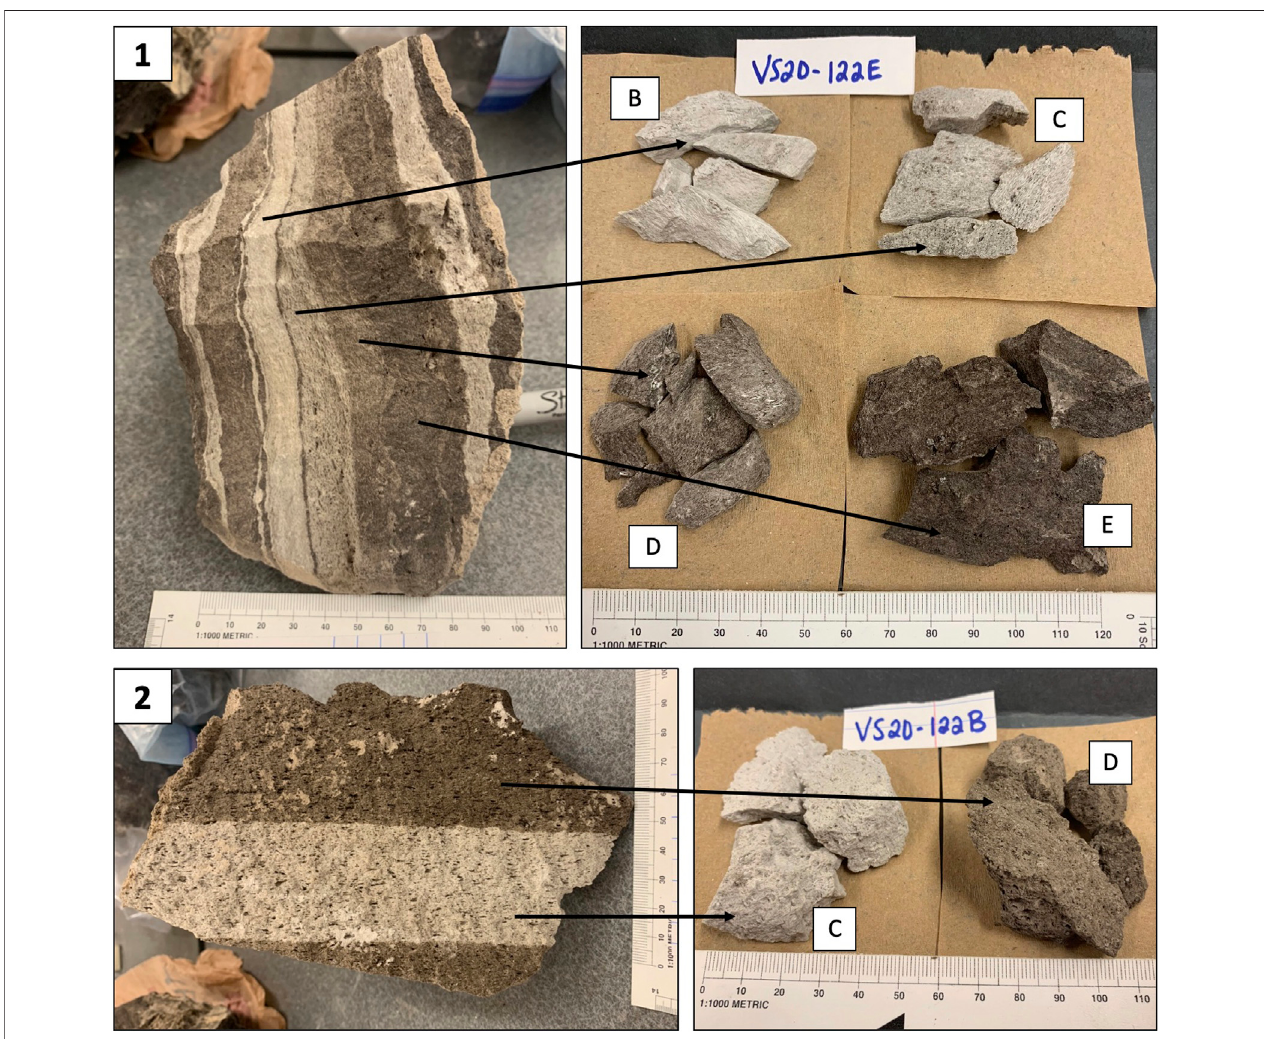
FIGURE6 | Examples ofhigh-silica rhyolite (HSR) Group compositionsassigned toseparatesfrom twodifferent samples. All banded pumices analyzed contained magmasofat leasttwoanduptofour HSRGroups.(1)VS20-122Ewastheonlypumicethatcontainedfour differentHSRmagmas (B – E) .(2)VS20-122Bisanexample of one pumice that contained two HSR magmas (C,D) . With respect to all pumices, HSR magmas contained within a single pumice were not always consecutive e.g., (A – C) . See Supplementary Appendix D for all pumice samples annotated with assigned Groups.